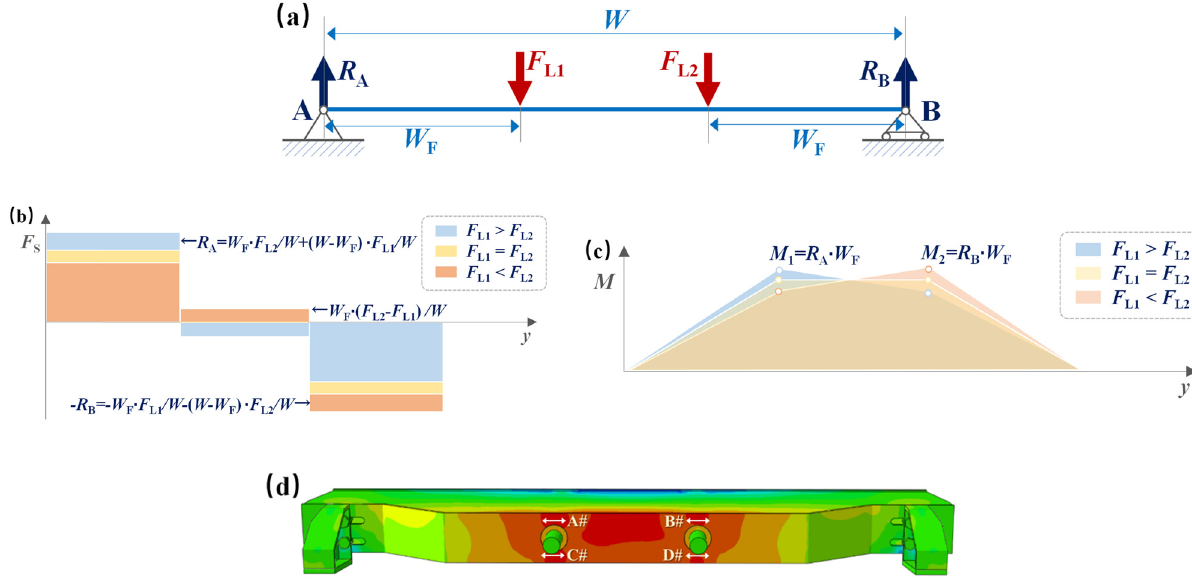
Figure 5: Simply supported beam analysis in longitudinal loading. ( a ) Mechanical structure; ( b ) shear force; ( c ) bending moment and ( d ) lateral